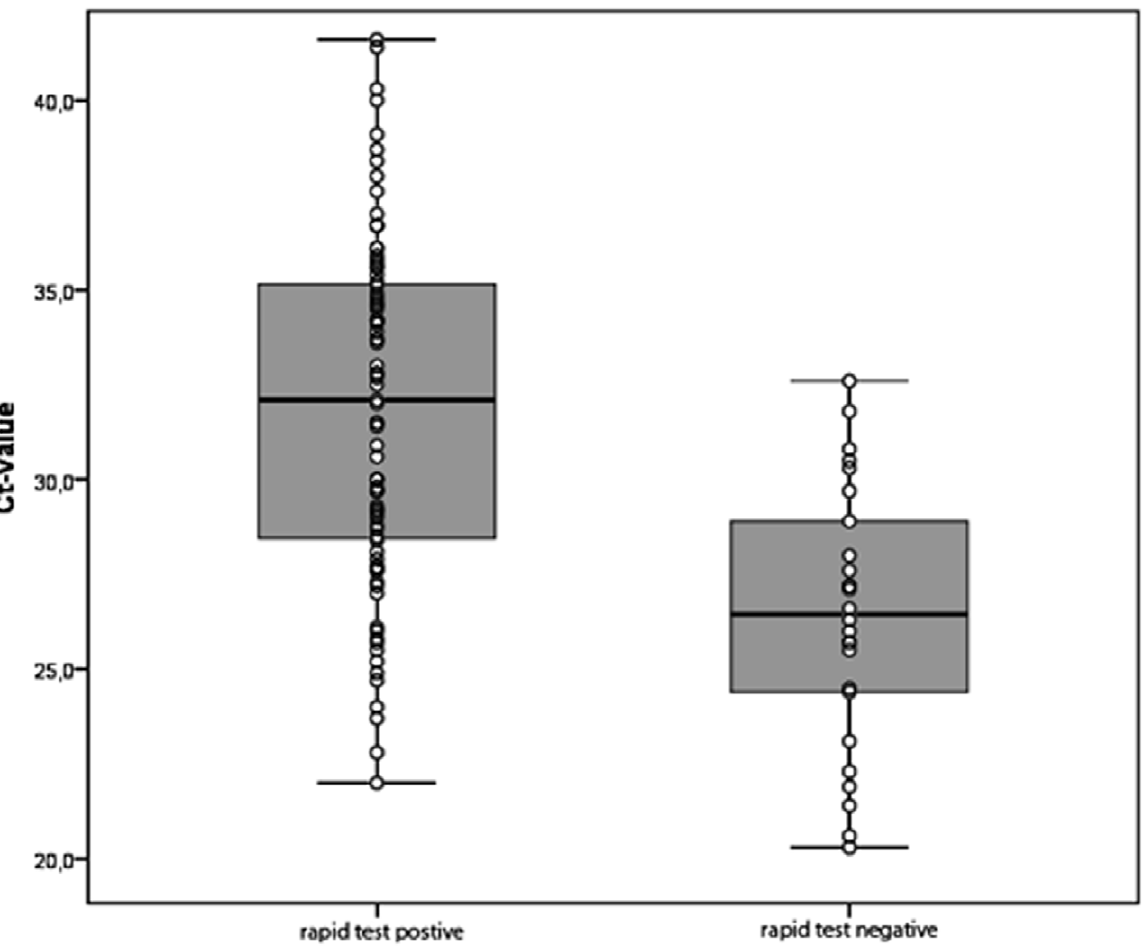
Figure 1. Ct values of respiratory specimens in 119 patients with RT-PCR-confirmed pandemic influenza A H1N1 (2009) virus infections. Ct values are compared between patients who had positive (Ct median 28.44) and negative (Ct median 31.9) results in the QuickVue Influenza A + B rapid test (p , 0.001). The box shows the median and interquartile range (box length). The whiskers represent minimum/maximum values. Individual values are presented as